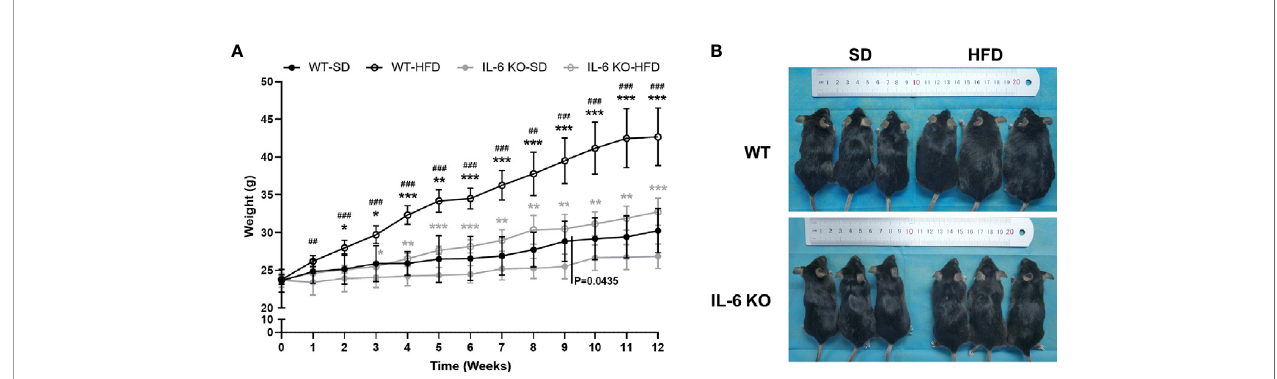
FIGURE 1 | The obesity models were established with WT and IL-6 KO mice. (A) Body weight curves of WT and IL-6 KO mice after SD or HFD (n = 5). (B) Photographs of mice in each group after 12 weeks of dietary intervention. Data were expressed as mean ± SD, * P < 0.05, ** P < 0.01, *** P < 0.001: compared to the same genotype; # P < 0.05, ## P < 0.01, ### P < 0.001: compared to the same diet.